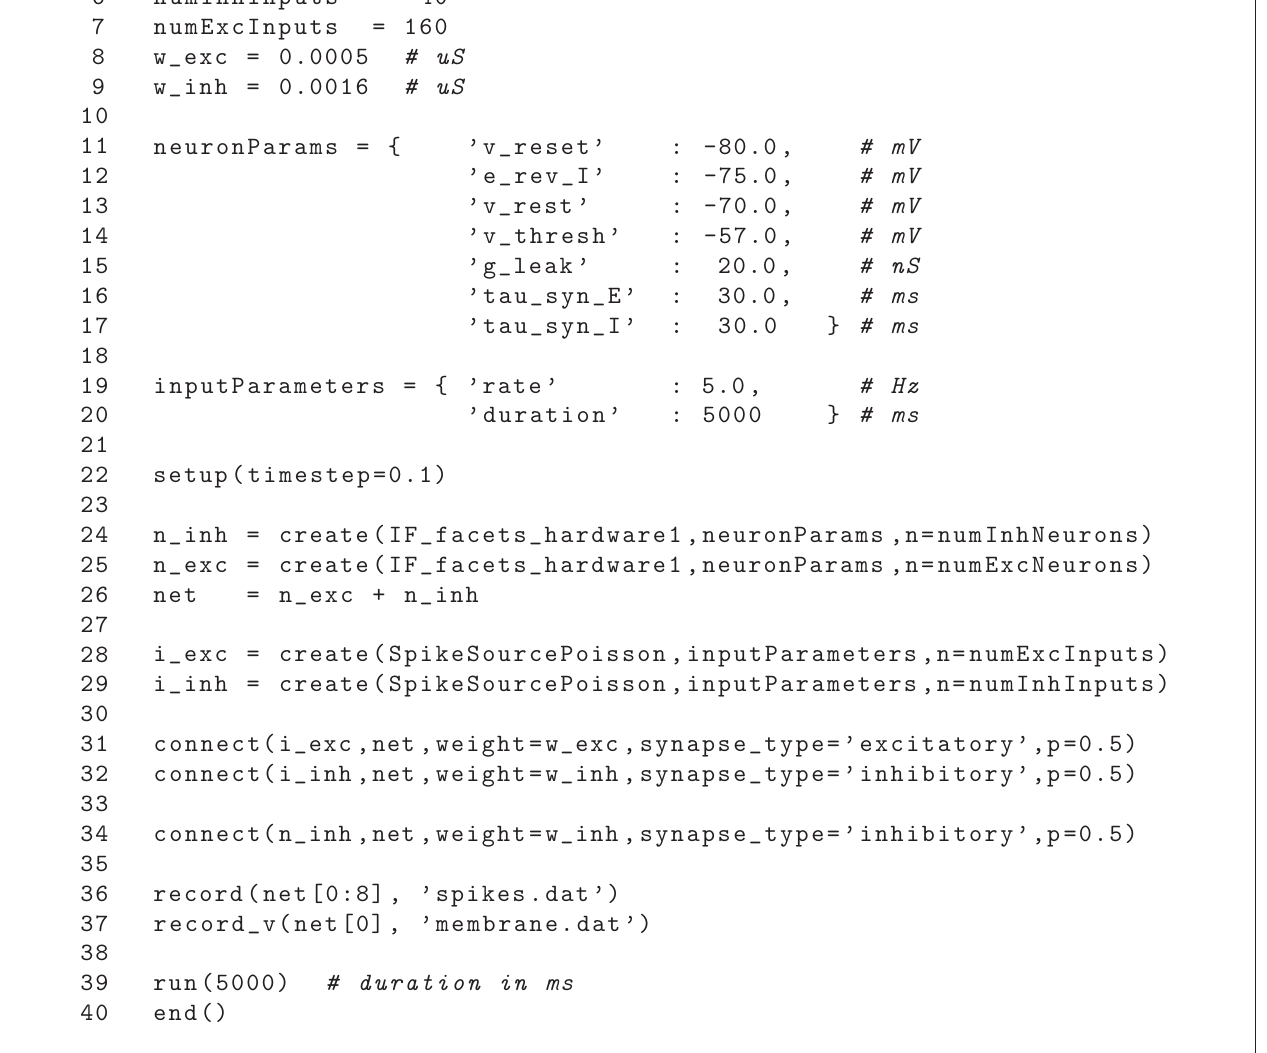
LISTING 1 | PyNN Example Script. For detailed explanation see